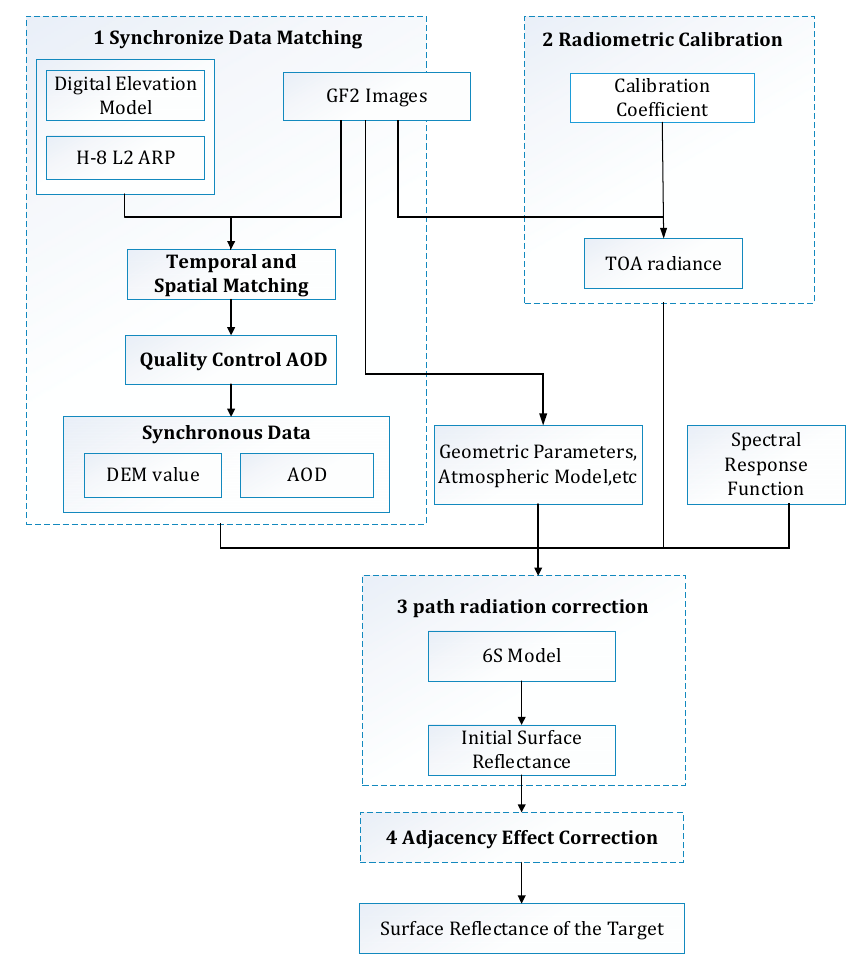
Figure 1. Flowchart of the QUAAC algorithm.